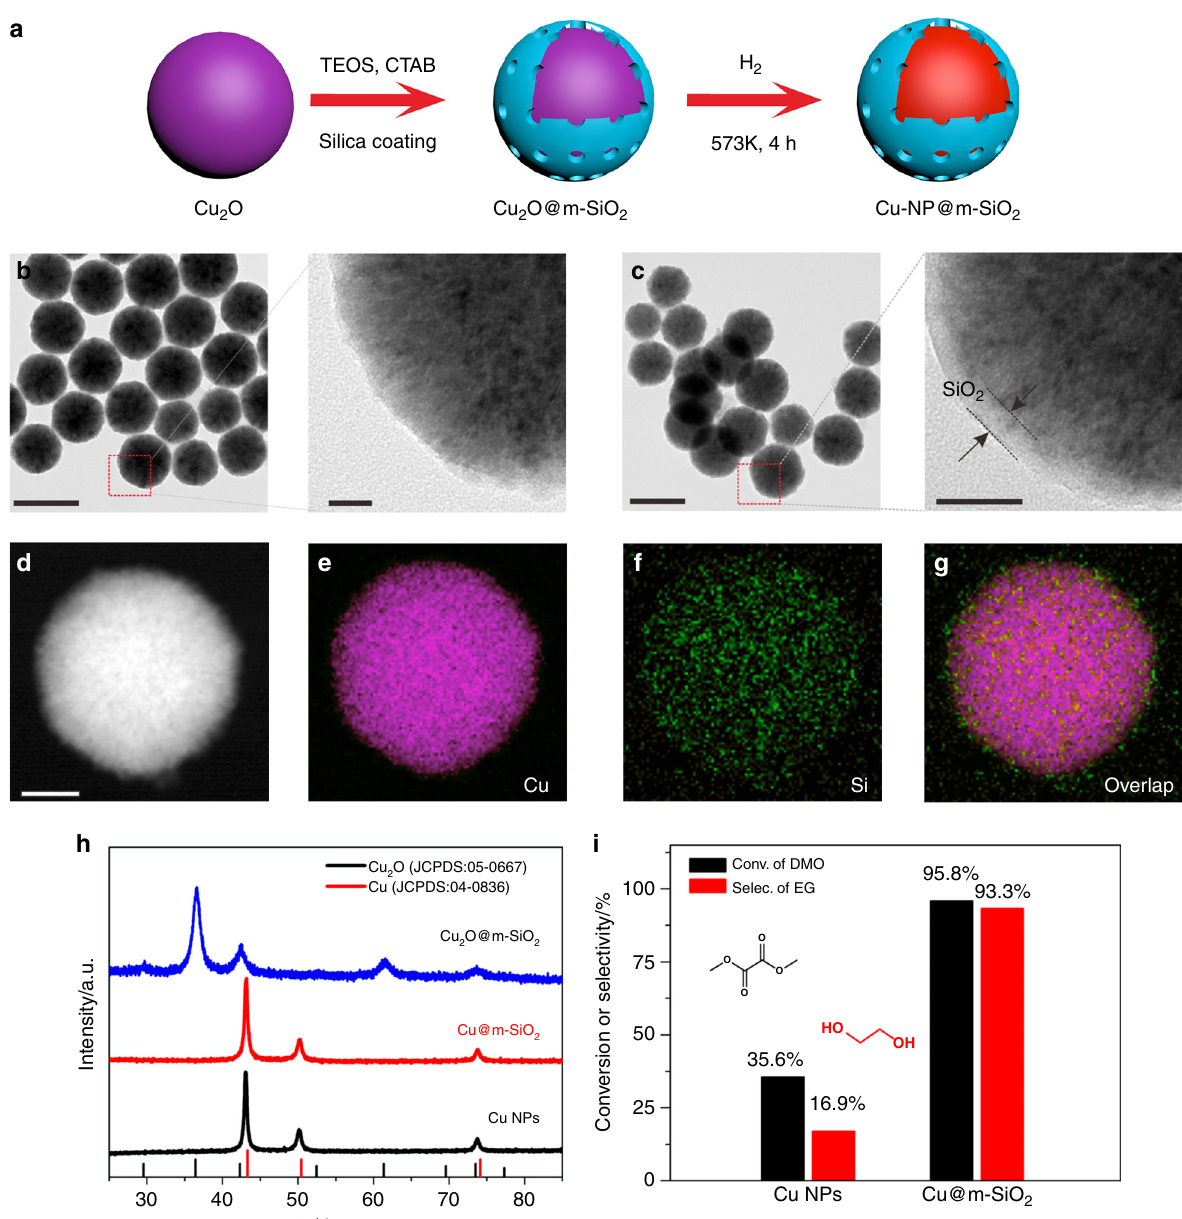
Fig. 3 Creating Cu – O – SiO x interfaces on Cu nanoparticles. a Scheme for the synthesis of Cu@m-SiO 2 ; b , c TEM images of as-prepared Cu 2 O nanoparticles and Cu 2 O@m-SiO 2 , respectively. d – g EDX mapping images of Cu 2 O@m-SiO 2 ; h X-ray powder diffraction (XRD) pattern of Cu NPs, Cu 2 O@m-SiO 2 and Cu@m-SiO 2 ; i Catalytic performance of Cu NPs and Cu@m-SiO 2 for the selective hydrogenation of DMO; Reaction conditions were as follows: H 2 /DMO = 80 mol/mol, P (H 2 ) = 3.0 MPa, T = 200 °C, LHSV = 2.4 h − 1 . Scale bars in b (left) and c (left) are 200 nm. Scale bars in b (right) and c (right) are 20 nm. Scale bar in d is 50